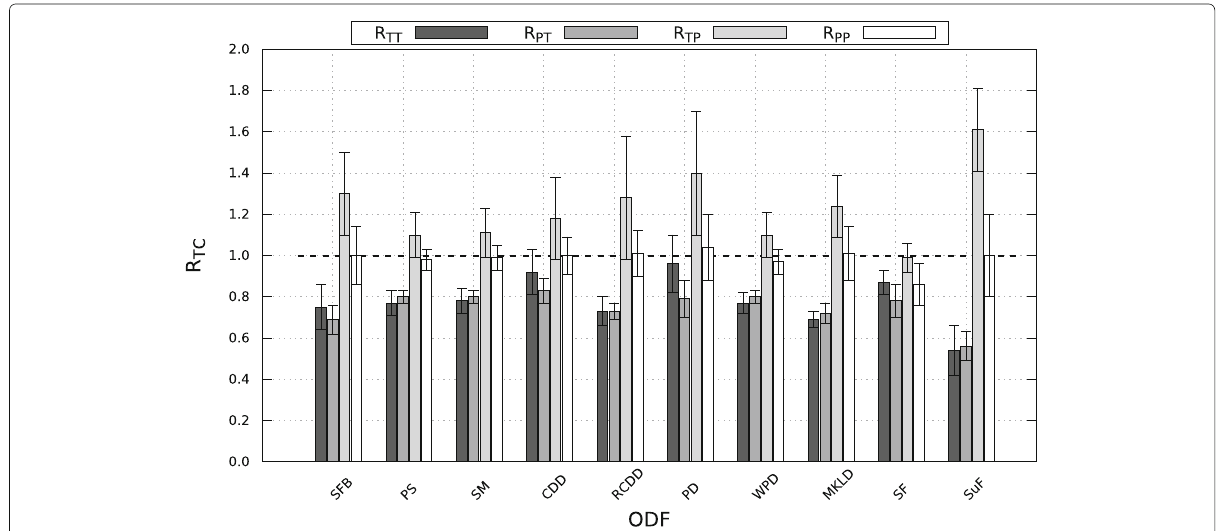
Fig. 7 Graphical representation of the user effort measure R TC for all the combinations of OSF and interactive correction schemes. R TC = 1 is